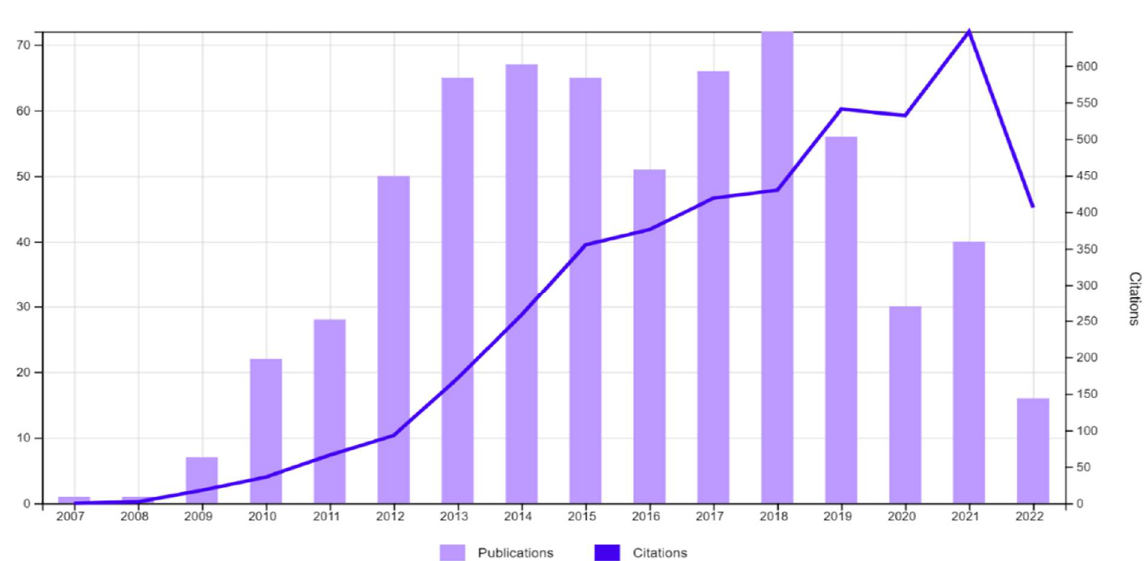
Figure 6. Affiliations’ Production over Time (Source: Biblioshiny).